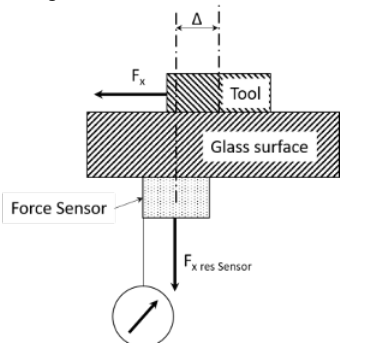
Figure 1: Schematic representation of the effects of the lateral forces on the sensor